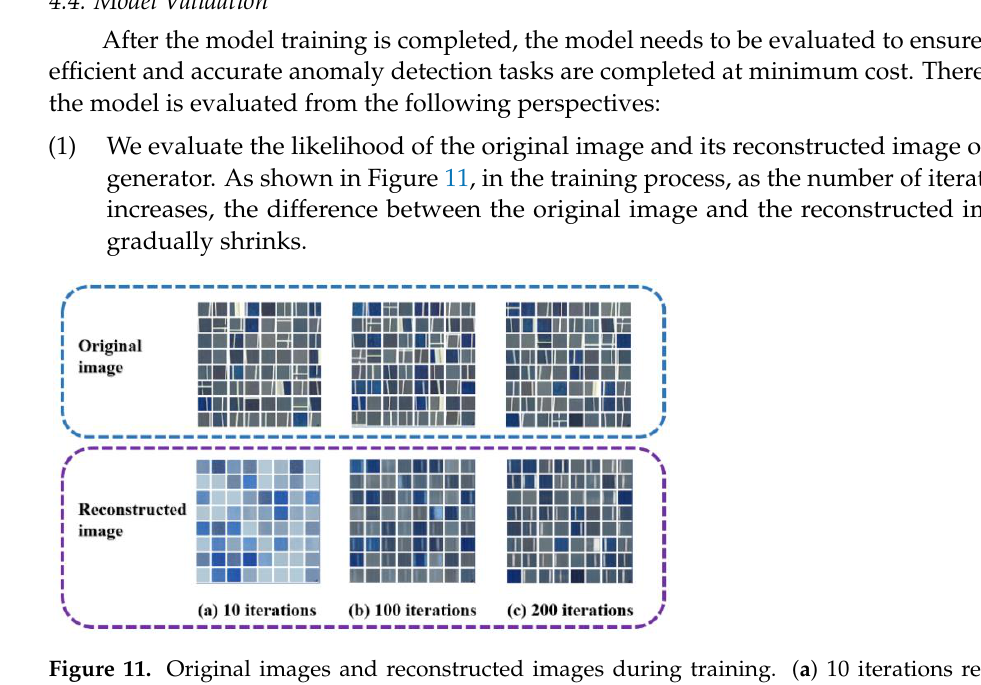
( b ) Figure 12. Data distribution comparison between the original image and its reconstructed image. ( a ) Positive sample; ( b ) Negative sample. (3) We evaluate the error between the latent space vectors of the original image and its reconstructed image. As shown in Figure 13a, the 𝑀(𝑧, 𝑧̃) of the positive samples (in blue color) is distributed around 10, but the 𝑀(𝑧, 𝑧̃) of the negative samples (in red color) is mainly distributed between 30 and 70. It can also be seen in Figure 13b. So, the 𝑀(𝑧, 𝑧̃) of the positive samples and negative samples has a clear decision bound- ary.